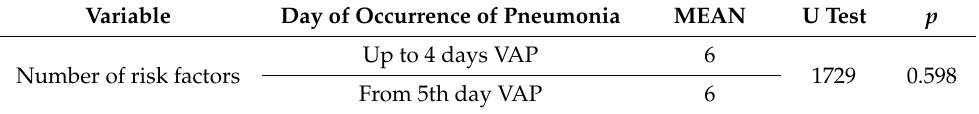
Table 10. The influence of the risk factor number in studied patients on VAP occurrence time. Variable Day of Occurrence of Pneumonia MEAN U Test p Up to 4 days VAP 6 1729 0.598 Number of risk factors From 5th day VAP 6